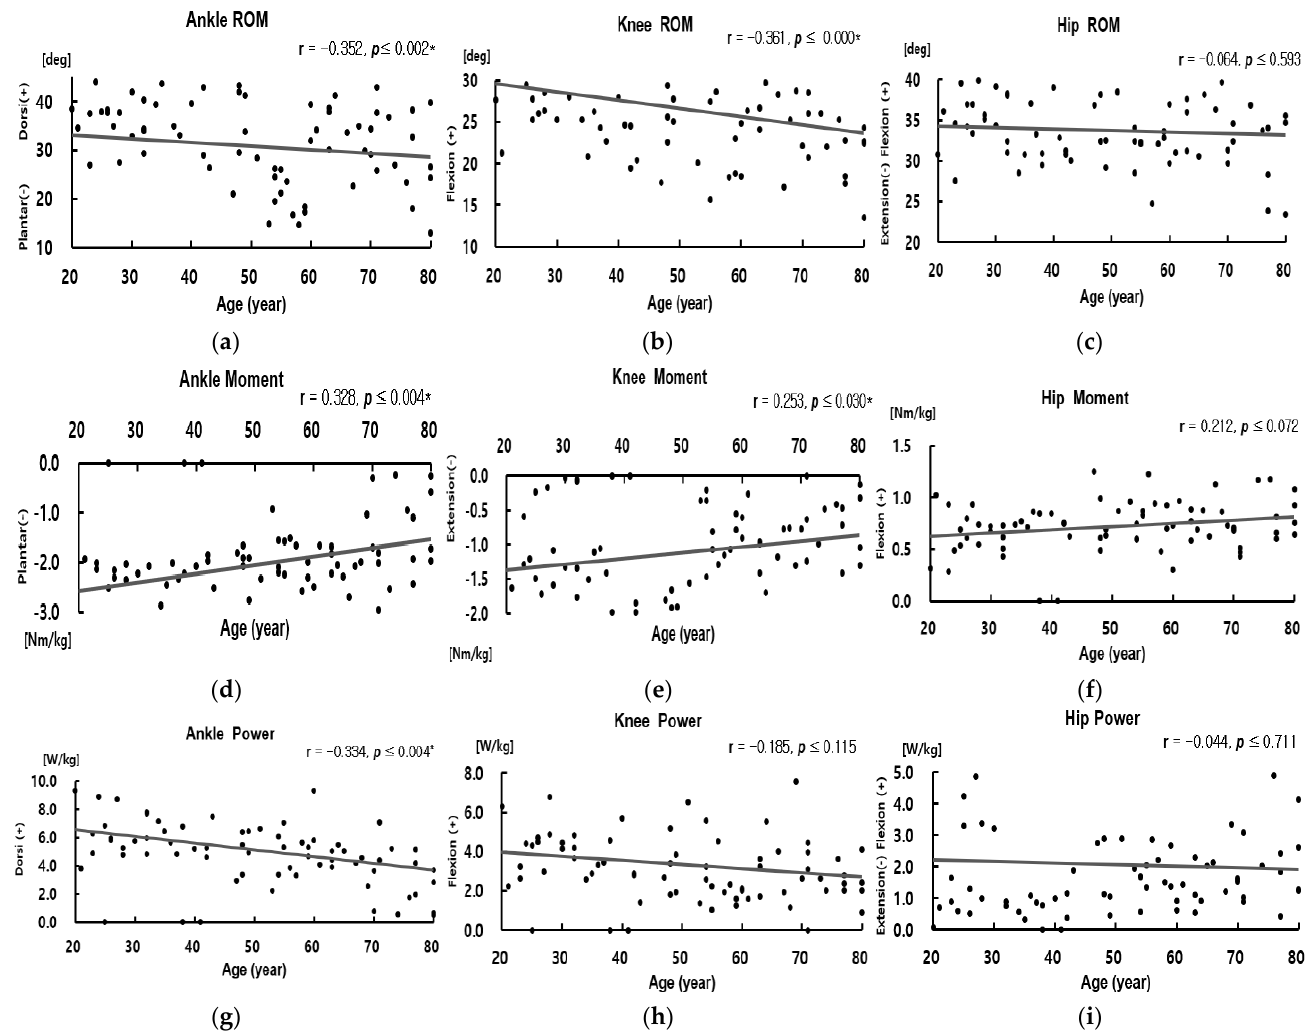
stride distance. * p < 0.05 indicates significant correlations between age and the variables.